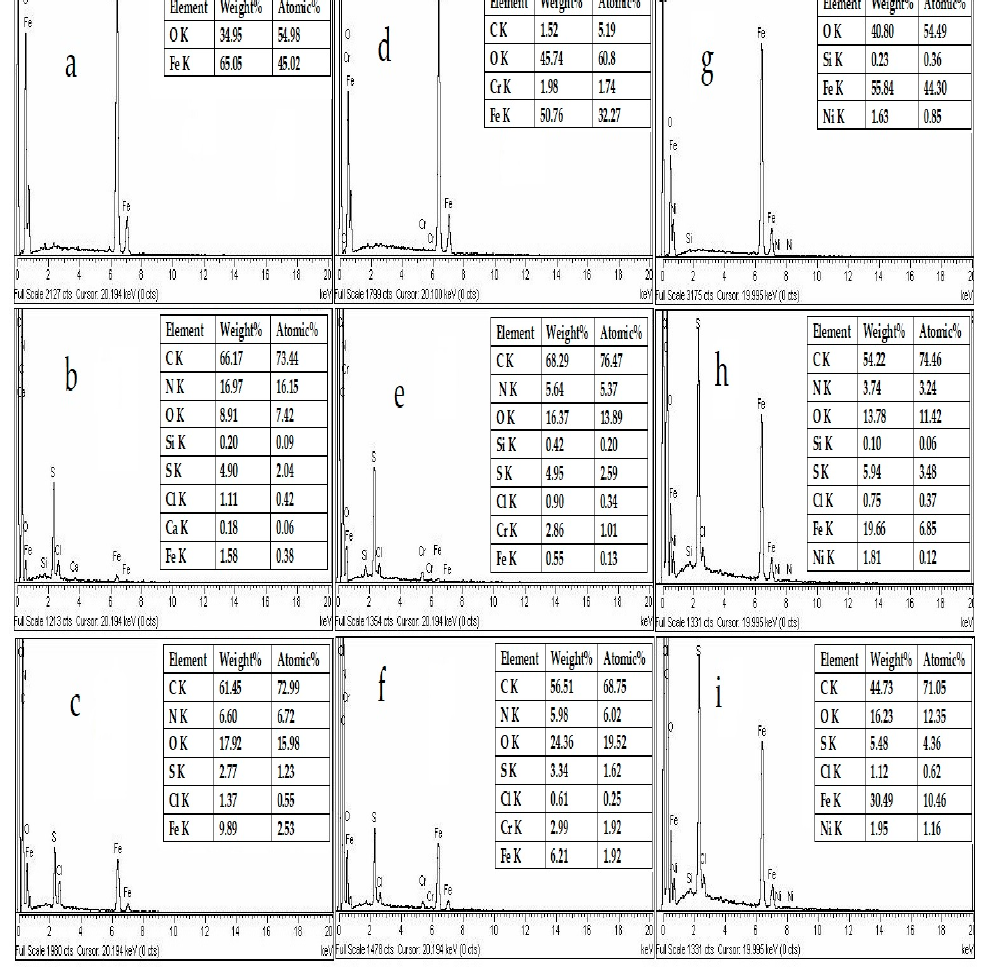
Figure 2. Energy Dispersive X-ray ( EDX) spectra of Fe 3 O 4 , PANI, and PANI/ Fe 3 O 4 before adsorption ( a – c ), adsorption of Cr (VI) ( d – f ) and Ni (II) ( g – i ).